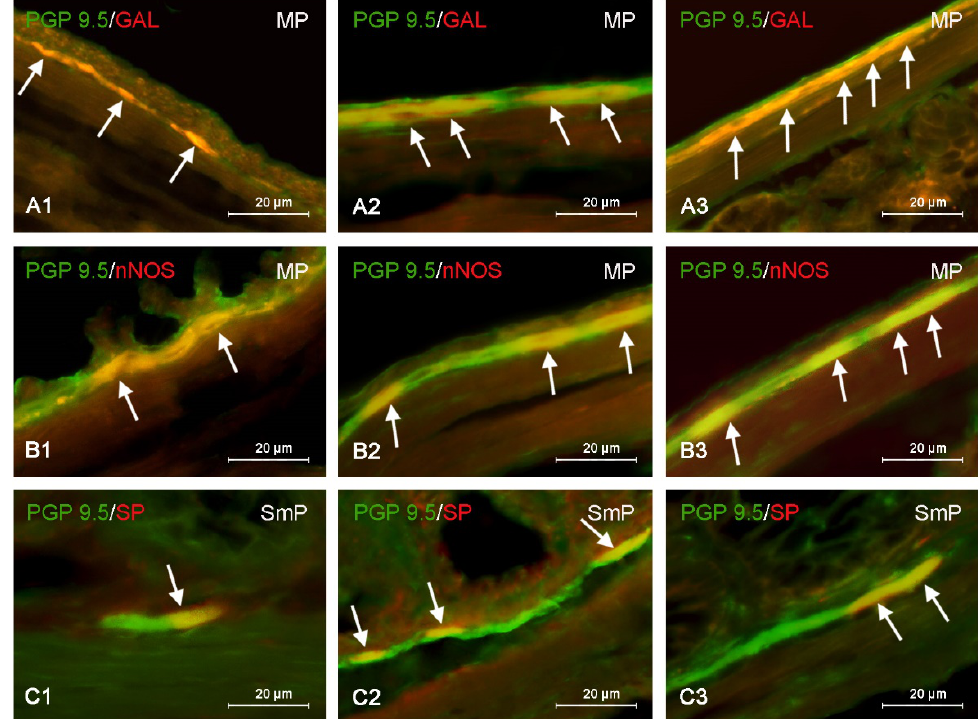
Figure 3. Distribution pattern of nerve cells immunoreactive to protein gene-product 9.5 (PGP 9.5)—used as pan neuronal marker and other substance studied: galanin (GAL), neuronal isoform of nitric oxide synthase (nNOS) or substance P (SP) in the myenteric plexus (MP) or submucous plexus (SmP) of mice distal colon under physiological conditions ( A1 , B1 , C1 ) and after administration of bisphenol A in low ( A2 , B2 , C2 ) and high dose ( A3 , B3 , C3 ). The pictures are the result of the overlap of both stainings. The arrows are pointing neurons immunoreactive for studied substances.